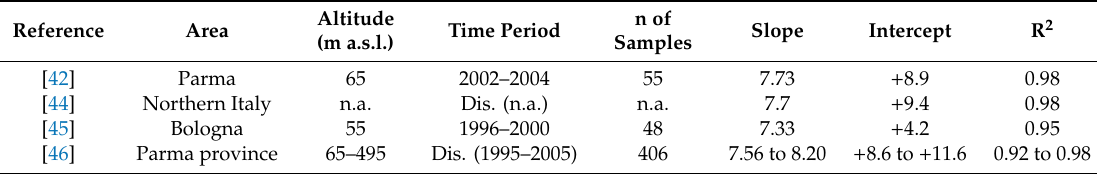
Table 1. Local meteoric water lines involving the foothills of the northern Italian Apennines, from literature (Dis. = discontinuous data). All the regression lines were obtained without weighting procedures. n of Altitude Slope Intercept R Time Period Reference Area Samples (m a.s.l.)